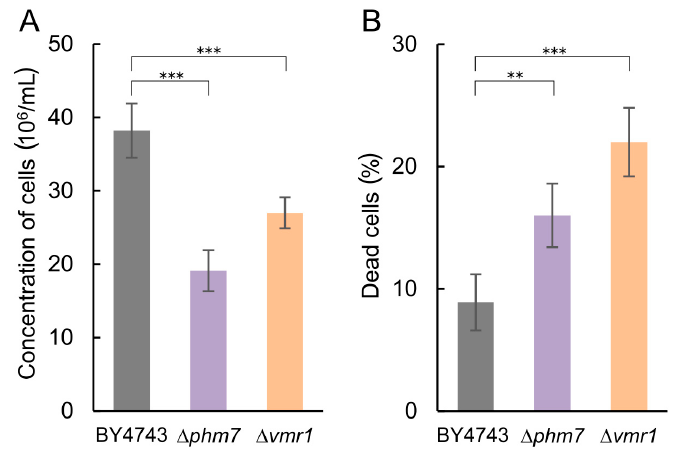
Figure 5. Growth characteristics of the BY4743 parent strain and ∆ phm7 and ∆ vmr1 knockout strains of S. cerevisiae cultivated in YPD medium with 14 mM KH 2 PO 4 and 5 mM MnSO 4 to the stationary growth stage (72 h). ( A ) cell concentration, ( B ) percentage of dead cells. Three replicates were performed for each experiment; mean ± s.d. is shown. Two-sample t-test was used to assess the statistical significance: *** p -value < 0.001, ** p -value < 0.01.